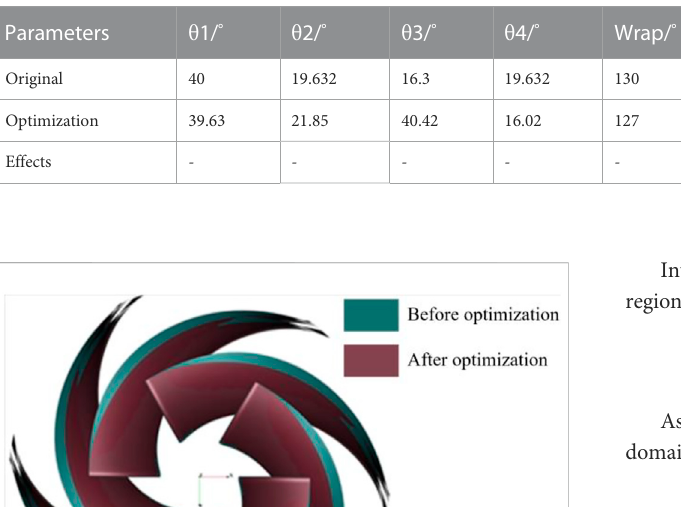
TABLE 2 Comparison of parameters before and after optimization.